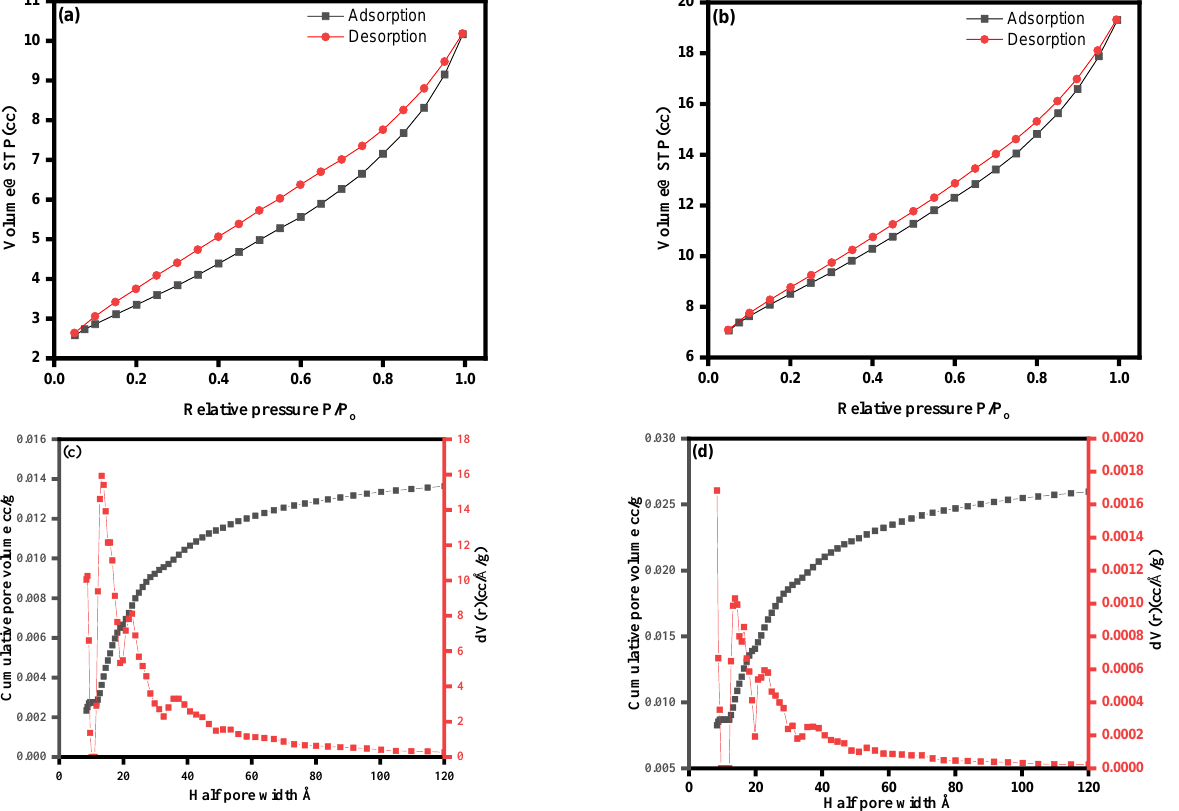
Figure 8. BET adsorption – desorption isotherm of ( a ) ZnO NPs and ( b ) ZnO – Ag nanocomposite with DFT pore-size distribution of ( c ) ZnO NPs and ( d ) ZnO – Ag nanocomposite. Table 2. BET surface area, pore size, and pore volumes of ZnO NPs, and ZnO – Ag nanocomposite. Catalyst